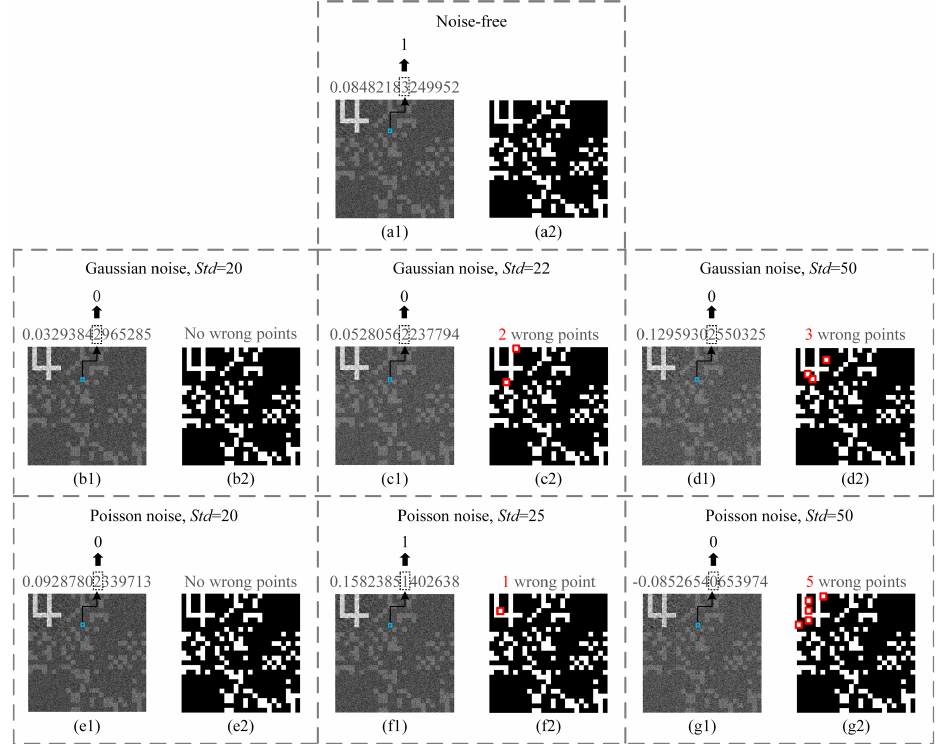
Figure 8. Performance comparisons between traditional CGI-based CKD protocol that utilizes the parity of decimals and our protocol, in the presence of additive white Gaussian noise and Poisson noise. ( a1,a2 ) are the recovered ghost image with a blue pixel being marked over it (showing the cryptographic key extraction process in a traditional CGI-based CKD protocol while utilizing the parity of some digits after the decimal point of the gray value of the pixel at (60,90) of the ghost image) and the binarized result by using our protocol, under the noise-free condition. ( b1 , b2 , c1 , c2 , d1 , d2 ) and ( e1 , e2 , f1 , f2 , g1 , g2 ) are recovered ghost images and their binarized results by using the traditional CKD protocol and our protocol, under Gaussian noise with a standard deviation ( Std ) of 20, 22 or 50 and Poisson noise with a standard deviation of 20, 25 or 50, respectively. The red squares mark the wrong